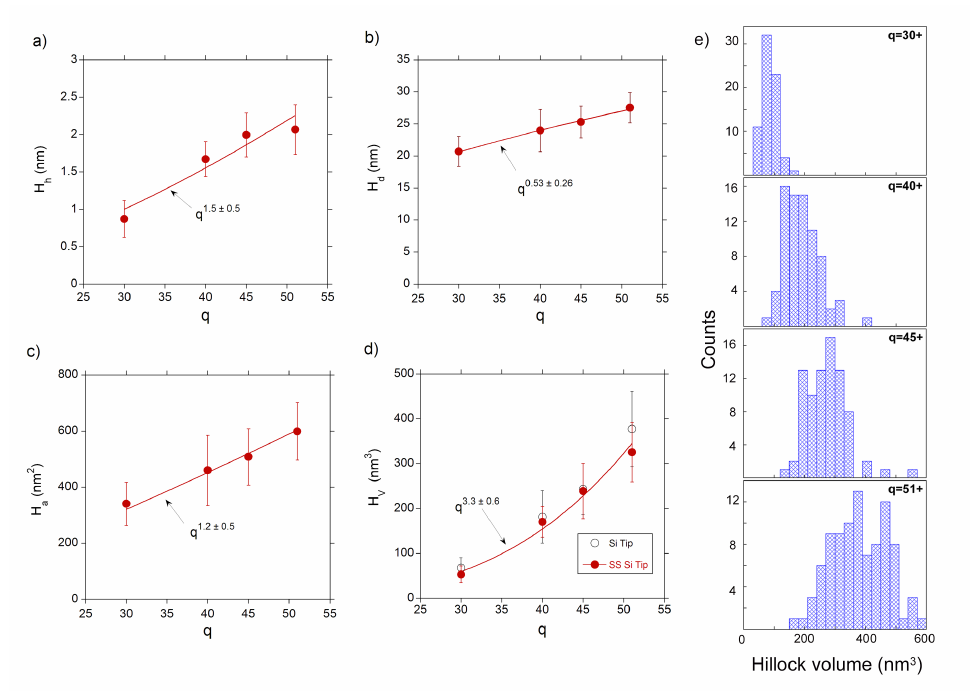
Figure 4. Average dimensions of hillocks induced in mica by projectiles of different initial charge state impinging at normal incidence: ( a ) height H h ; ( b ) diameter H d ; ( c ) area H a ; and ( d ) volume H V . Solid lines depict the scaling of each dimension with q , fitted to power laws. The influence of using tips of different sharpnesses is also illustrated for the hillock volume; ( e ) histograms showing the distribution of hillock volumes for the different initial charge